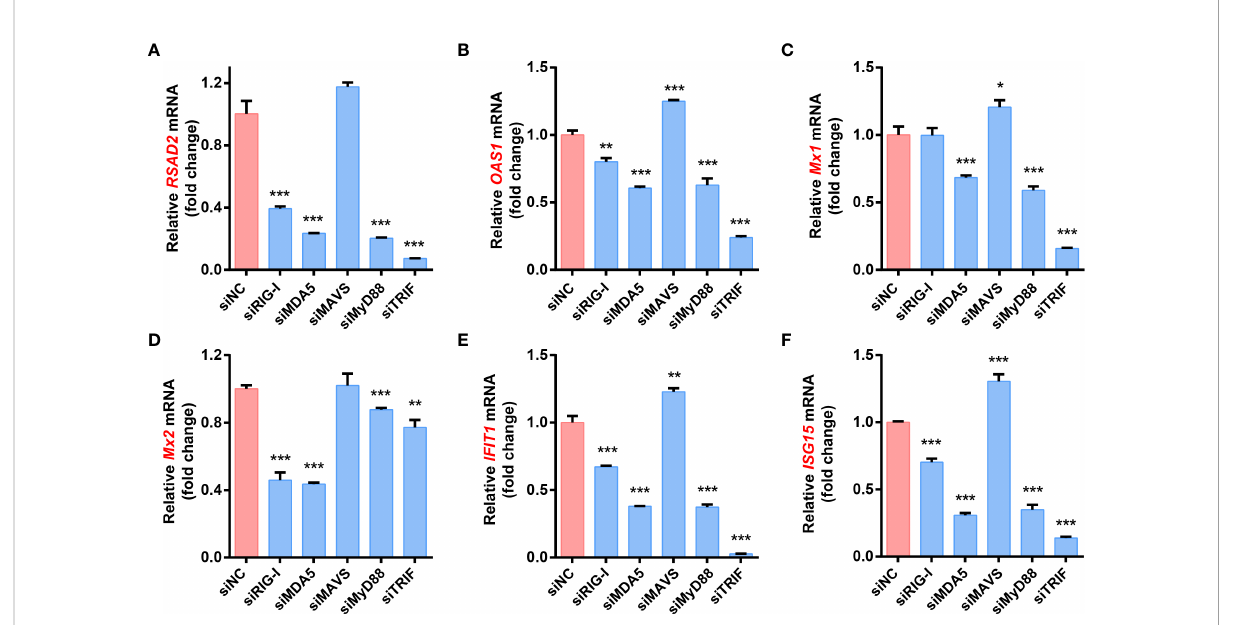
FIGURE 6 RLRs and TLRs signaling pathways are involved in the production of ISGs during FJzz1 infection. LLC-PK1 cells were infected with FJzz1 at an MOI of 0.01 for 18 h, and total cellular RNA was extracted to determine the mRNA level of RSAD2 (A) , OAS1 (B) , Mx1 (C) , Mx2 (D) , IFIT1 (E) , and ISG15 (F) by RT-qPCR. These data are representative of the results of three independent experiments and error bars represent standard deviations. Asterisks indicate statistical signi fi cance.*, P < 0.05; **, P < 0.01; ***, P <